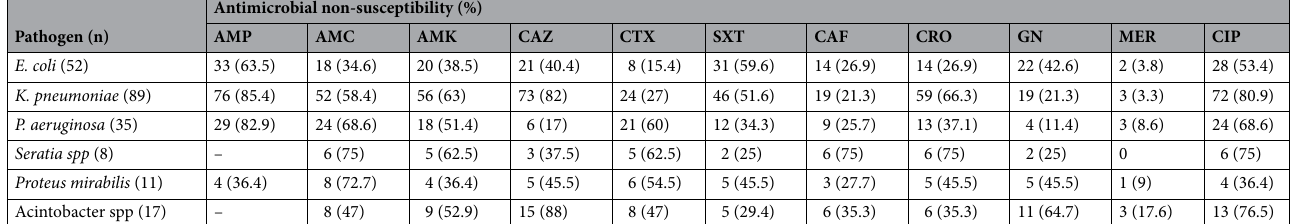
Table 5. Non-susceptibility rates of the most prevalent gram negative bacteria. AMP, ampicillin (10 μg); AMC, Amoxicillin-Calvulanic acid (20/10 μg); AMK, Amikacin(30 μg); CAZ, Ceftazidime (30 μg); CTX,